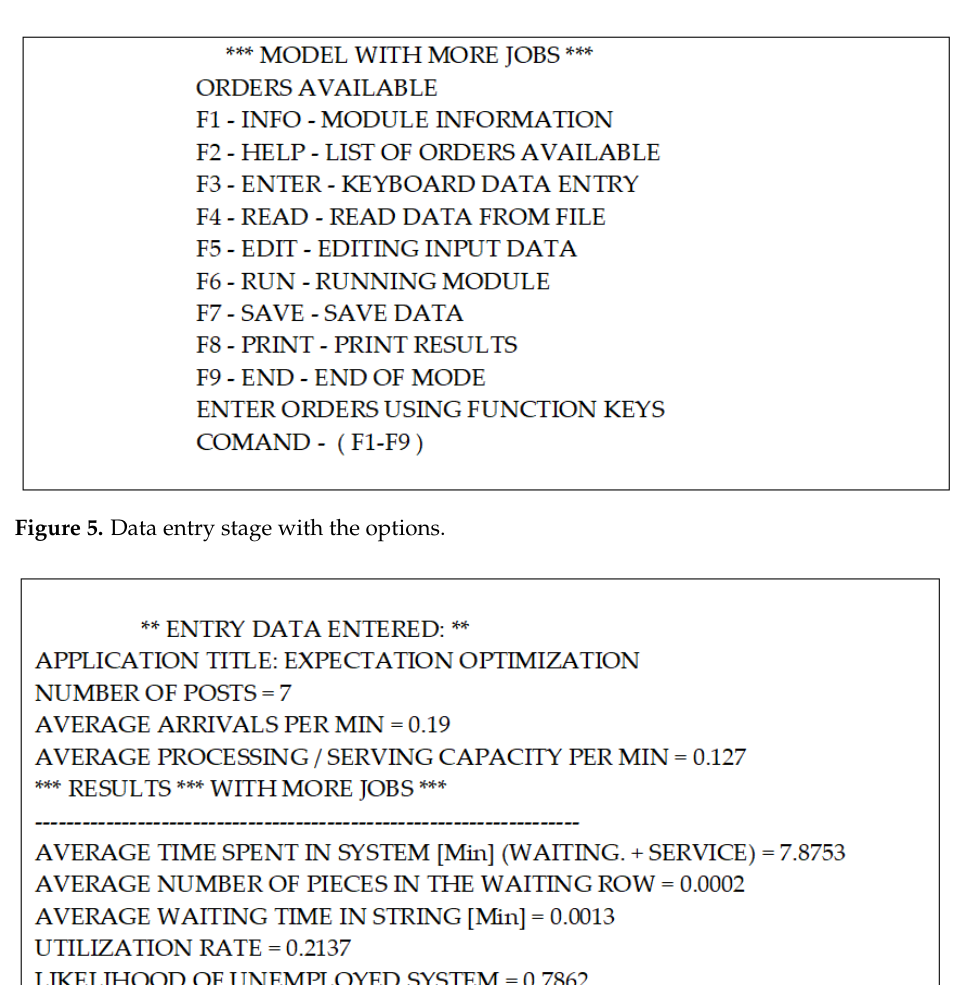
16 of 35 Figure 4. The first communication screen.